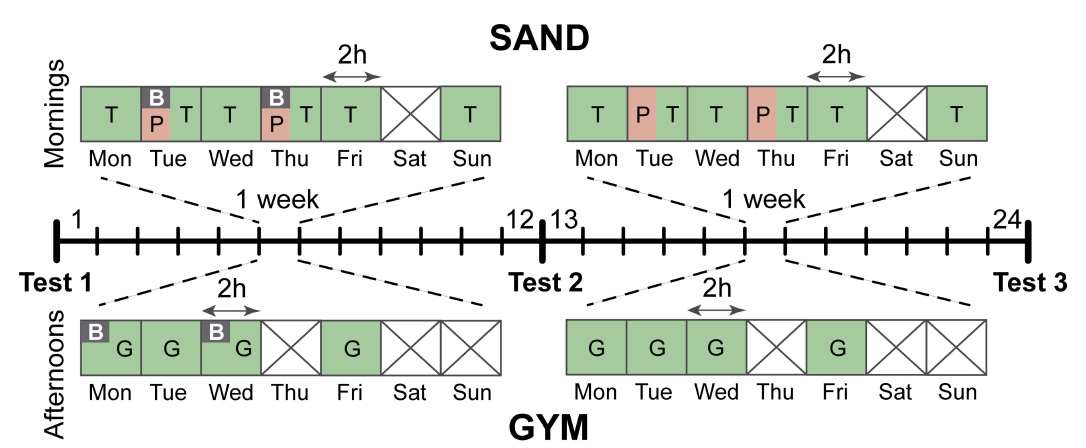
Figure 1. Experimental procedure showing weekly sessions for 24 weeks. Test 1: baseline; Test 2: post-balance training; Test 3: post-sand training. T: technical and tactical training, B: balance training, P: physical training, G: gym training. Days without training are displayed with crossed